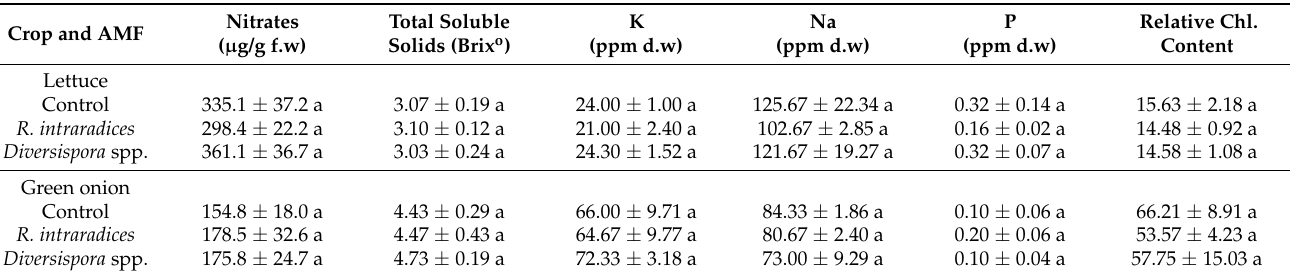
Table 3. Nitrate content, total soluble solids, potassium, sodium, and phosphorus concentrations, fresh weight, and relative chlorophyll content of lettuce and green onion at harvest after application of two arbuscular mycorrhizal inocula ( R. intraradices or Diversispora spp.) or without (control). Different letters within row (average values ± SE) indicate significant differences ( p <